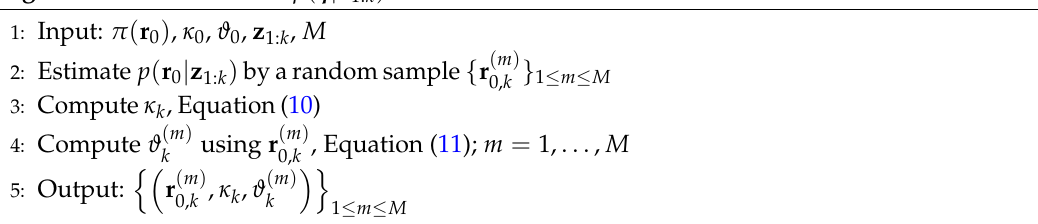
Algorithm 1 Estimation of p ( η | z 1: k